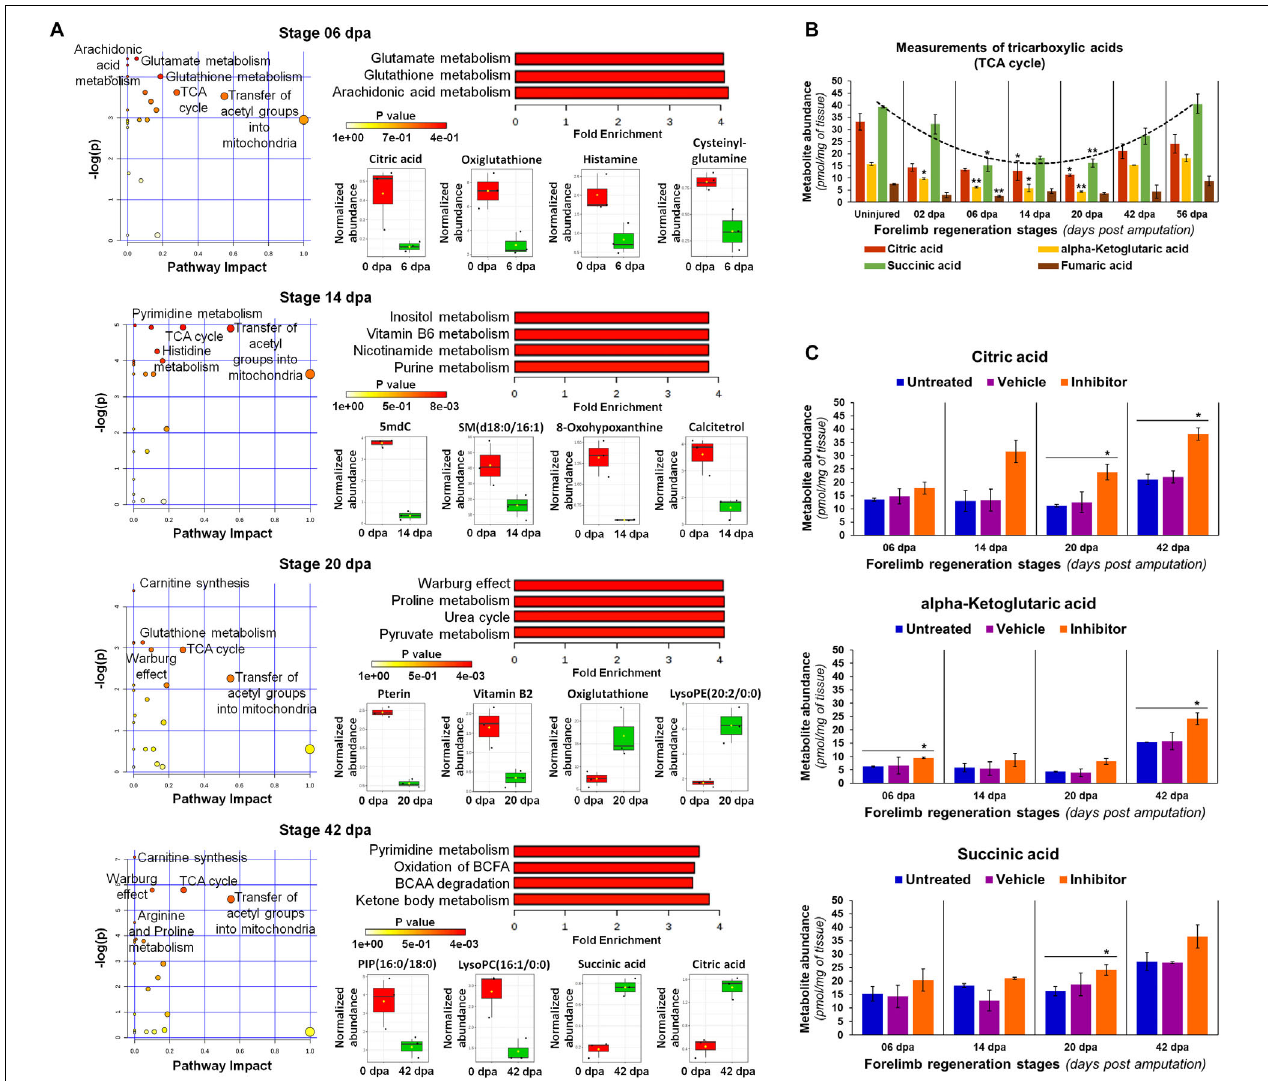
FIGURE 11 | Metabolic analyses in key regeneration stages. (A) Pathway analysis by global network topology evaluation with relative-betweenness centrality measure to estimate the importance of nodes. Different dot sizes represent the matched pathway status. Quantitative Metabolite Set Enrichment Analysis (QMSEA) is shown next with the metabolite sets more enriched only, using human pathway-associated metabolite sets SMPDB as reference through a global test. The box and whisker plots display some representative metabolites with a significant differential abundance (2-fold change threshold, P < 0.05 with unpaired t -Student test vs uninjured condition). BCFA: branched-chain fatty acids; BCAA: branched-chain amino acids. (B) Abundance validation of some tricarboxylic acids (TCA). Illustrative trend line for succinic acid is shown in a dotted line ( R 2 > 0.9). Data in the bar plot are represented as mean ± s.e.m. ( n = 3); *, P < 0.05; one-way ANOVA with post hoc Tukey–Kramer test vs uninjured condition. (C) Quantification of some tricarboxylic acids after diverse treatments. Inhibitor was the Lin28-1632, and the vehicle 0.75 × PBS with 0.002% DMSO. Data in the bar plots are represented as mean ± s.e.m. ( n = 3); *, P < 0.05; one-way ANOVA with post hoc Dunnett test vs untreated control